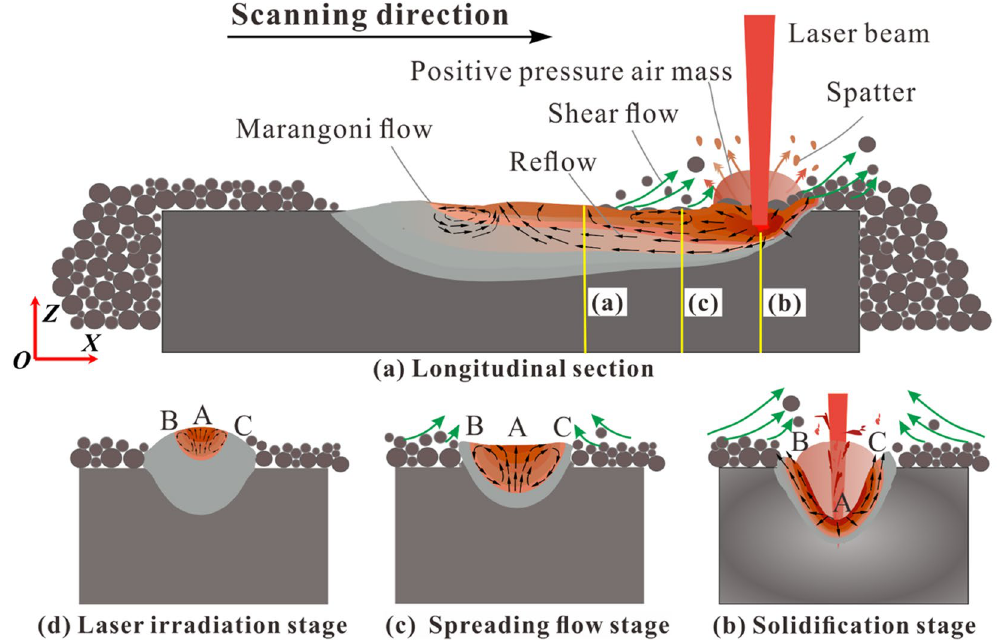
Figure 15 Schematic illustration of the molten pool formed during LPBF